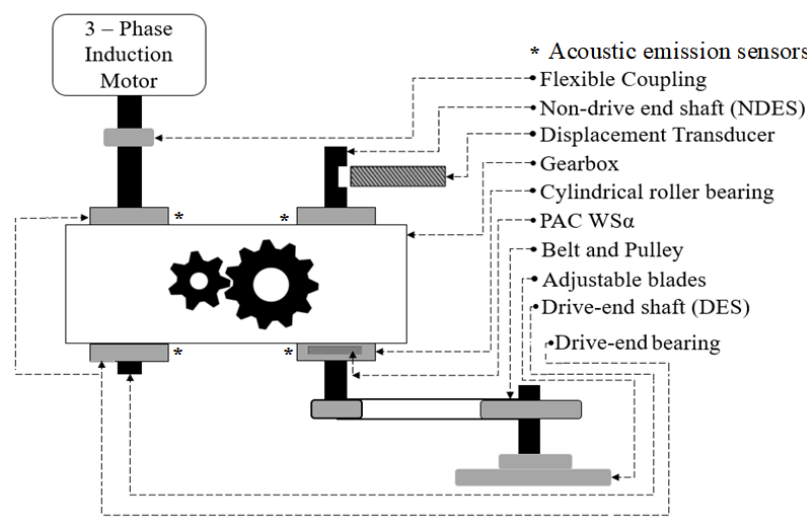
Figure 5. Block diagram of the bearing data collection testbench. Table 2. The Smart Health Safety Environment (SHSE) acoustic emission datasets to test the activity of the proposed algorithm in normal and abnormal bearing